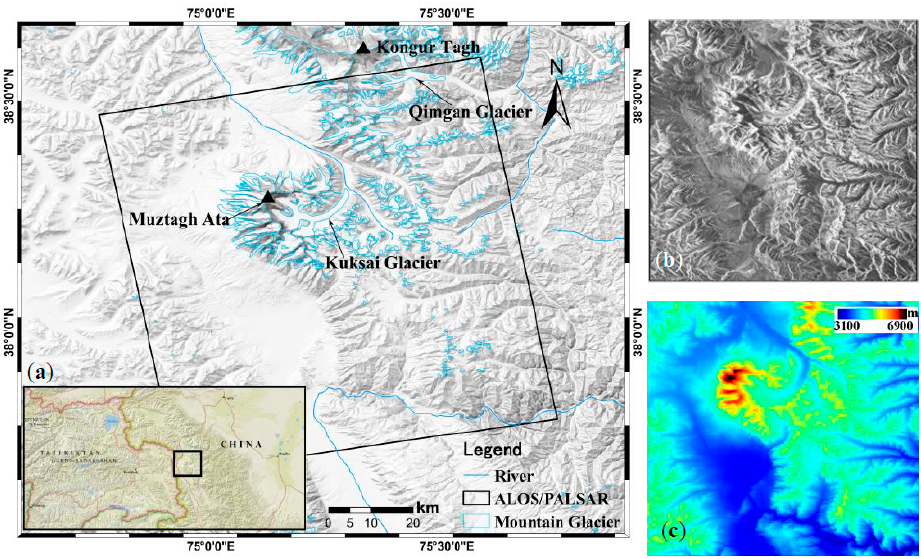
Figure 1. ( a ) The location of the study area superimposed on a shaded relief image; ( b ) The synthetic-aperture radar (SAR) intensity image; ( c ) The terrain elevation corresponding to the SAR image coverage.